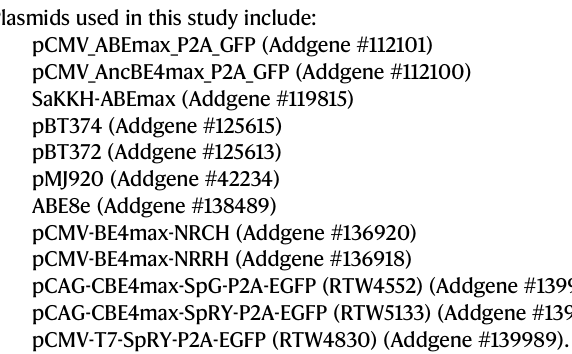
Fig. 7 | sgRNA-dependent DNA off-target activity of the base-editing system. a – c sgRNA-dependent off-target DNA sites, as evaluated by GUIDE-seq analysis, of LRF_bs_3 (LRF 4C) ( a ), LRF_bs_2 (LRF 8C) ( b ), and KLF1_bs_1 (LRF 2T and KLF1) ( c ) sgRNAs in HEK293T cells. sgRNAs were coupled with a Cas9-nuclease corre- sponding to the Cas9 nickase included in the base editor (Cas9-SpRY for LRF_bs_3 andLRF_bs_2sgRNAs,andCas9forKLF1_bs_1sgRNA).Theprotospacertargetedby each sgRNA and the PAM are reported on top of each panel, followed by the off- target sites and their mismatches with the on-target (highlighted in color). The number of sequencing reads, the chromosomal coordinates (Human GRCh37/ hg19), and the site of each off-target are reported. d – f Frequency of C-G to T-A